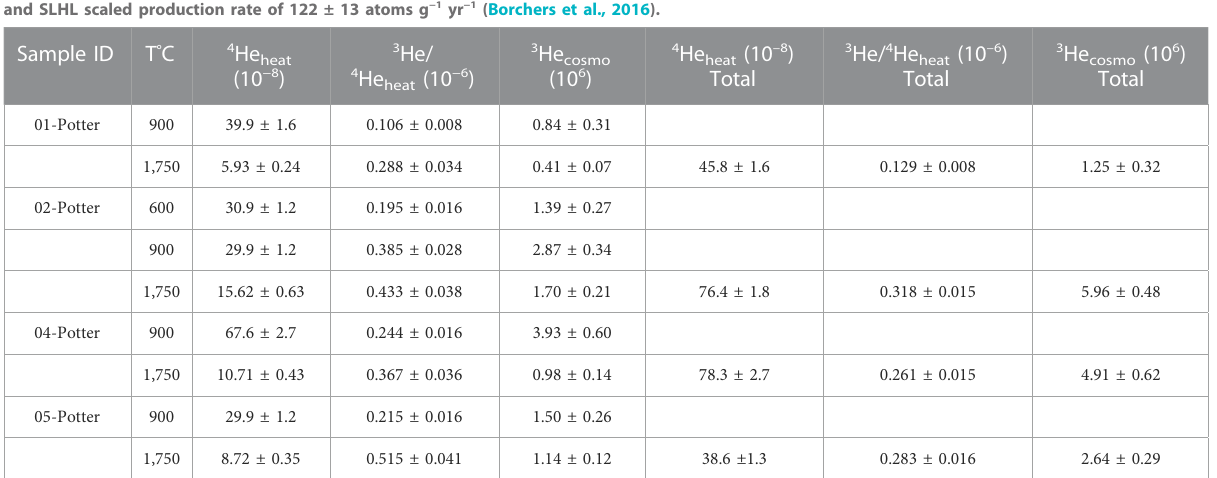
TABLE 5 Data for each heating step. The total 3 He cosmo concentrations have been calculated by summing the 3 He excesses from all heating steps. 1 Altitudes were measured with a Differential GPS Trimble Path fi nder ProXH. Accuracy of 10 cm in all axes. 2 The height (h) of the sample means cm above the